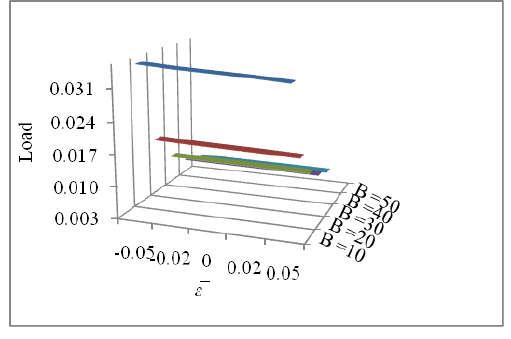
Figure 7. Profile of load bearing capacity with regards to  and